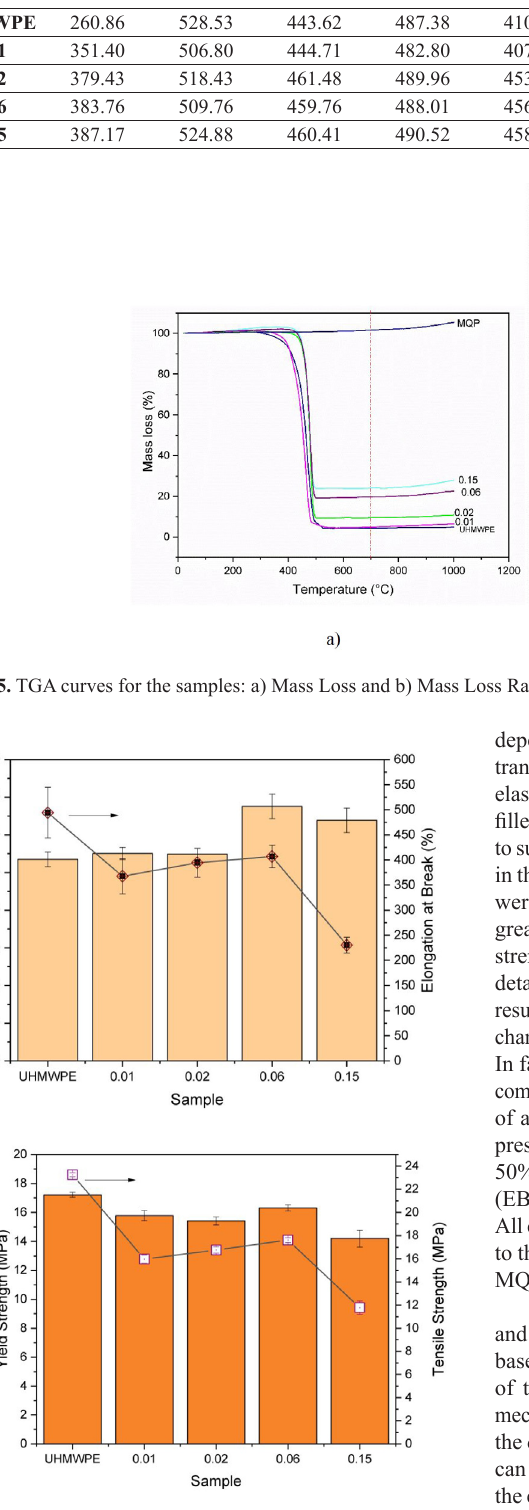
Figure 6. Mechanical Properties for the samples: a) Elastic Modulus and Elongation at Break; b) Yield Strength and Tensile